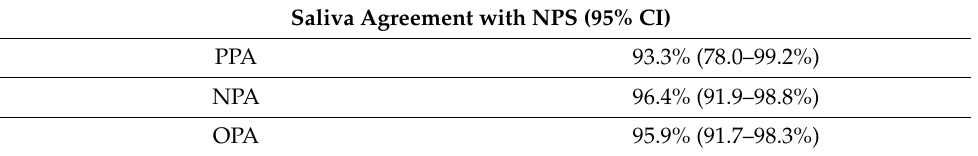
Table A4. Agreement values: Children.